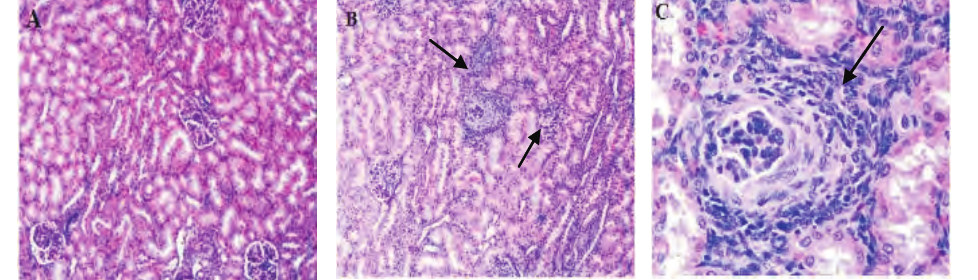
Figure-2. Histopathological findings of kidney of lambs exposed to nano zinc at dose of 20mg/kg body weight on 25days oral administration. (A) Kidney of the control group. There are no significant lesions (10x). (B) Kidney of the nano zinc group arrows show multifocal interstitial nephritis (infiltration of inflammatory cells) (10x). (C) Kidney of the nano zinc group arrow shows glomerular fibrosis (40x).